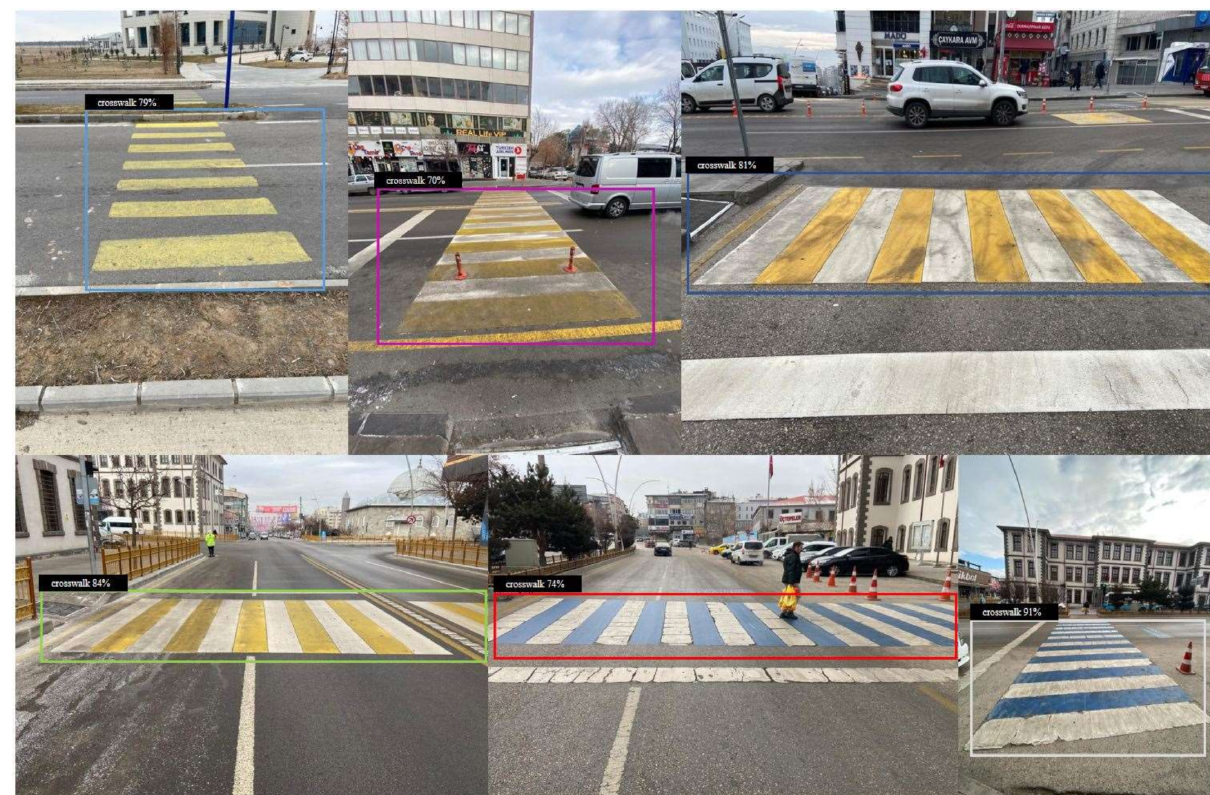
Figure 8. Detected “Pedestrian Crosswalk” from the CRWALKval dataset using